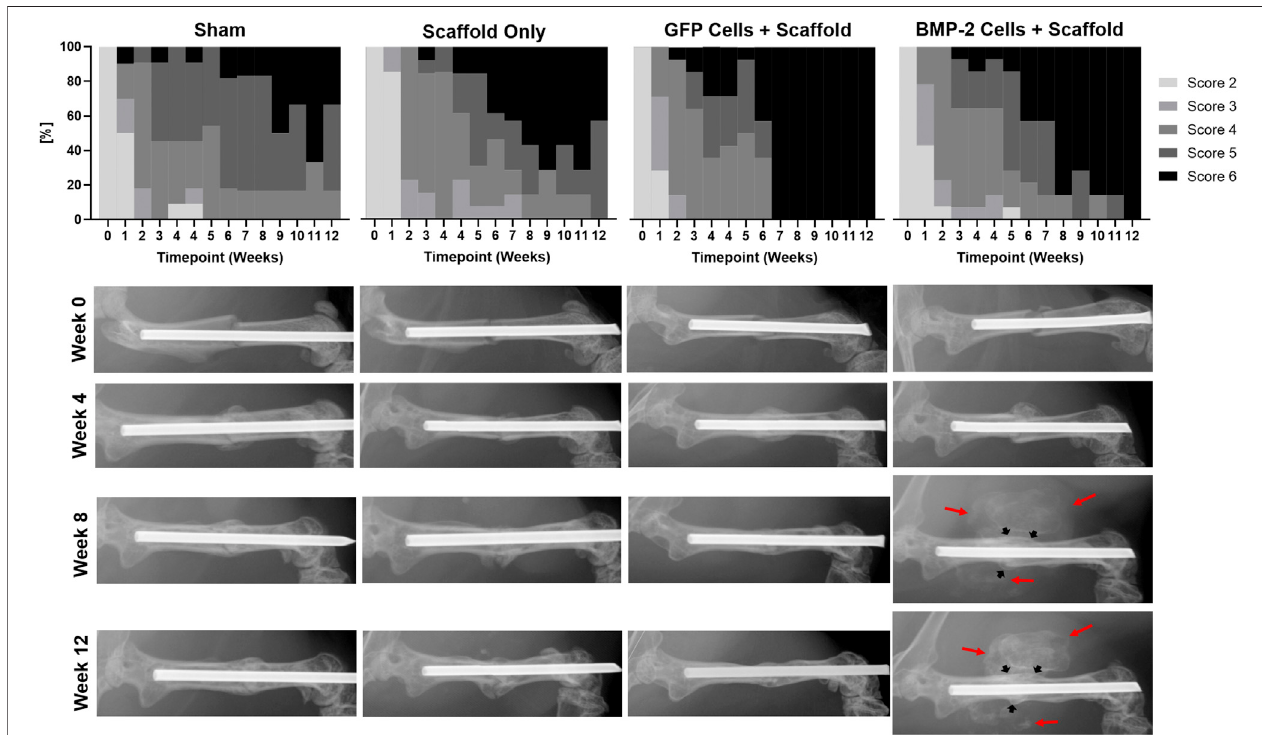
FIGURE 3 | Radiographic scoring of atrophic non-unions treated with sham (no scaffold or cells) control, cryogel (acellular) scaffold only, scaffolds seeded with GFP+cells,andscaffoldsseededwithcellsexpressingBMP-2.DuetothetreatmentwithGCVandinsuf fi cientrescue,lessthan50%oftheCol1-tkscaffoldonlyorsham groups had complete bridging at 12 weeks. Comparatively, the GFP+ and BMP-2+ cells were the only groups to achieve full bridging by week 12, with GFP+ cells displaying a score of 6 by week 6. Scoring of the radiographs demonstrated no signi fi cant difference between any groups at 6 weeks. However, there were signi fi cant differences between both the sham and scaffold groups as compared to both the GFP and BMP-2 groups at 12 weeks ( χ 2 , p < 0.05). Representative radiographs are shown from the time of fracture (Week 0) and at 4, 8, and 12 weeks. The BMP-2+ cellularized scaffolds possessed visually mineralized scaffolds surrounding the non-union site beginning 1 – 3 weeks following implantation (red arrows) in addition to the endogenous fracture callus (black